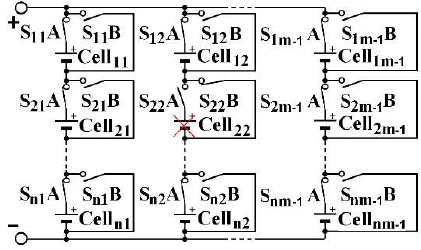
Figure 6. Fault tolerant SP architecture.